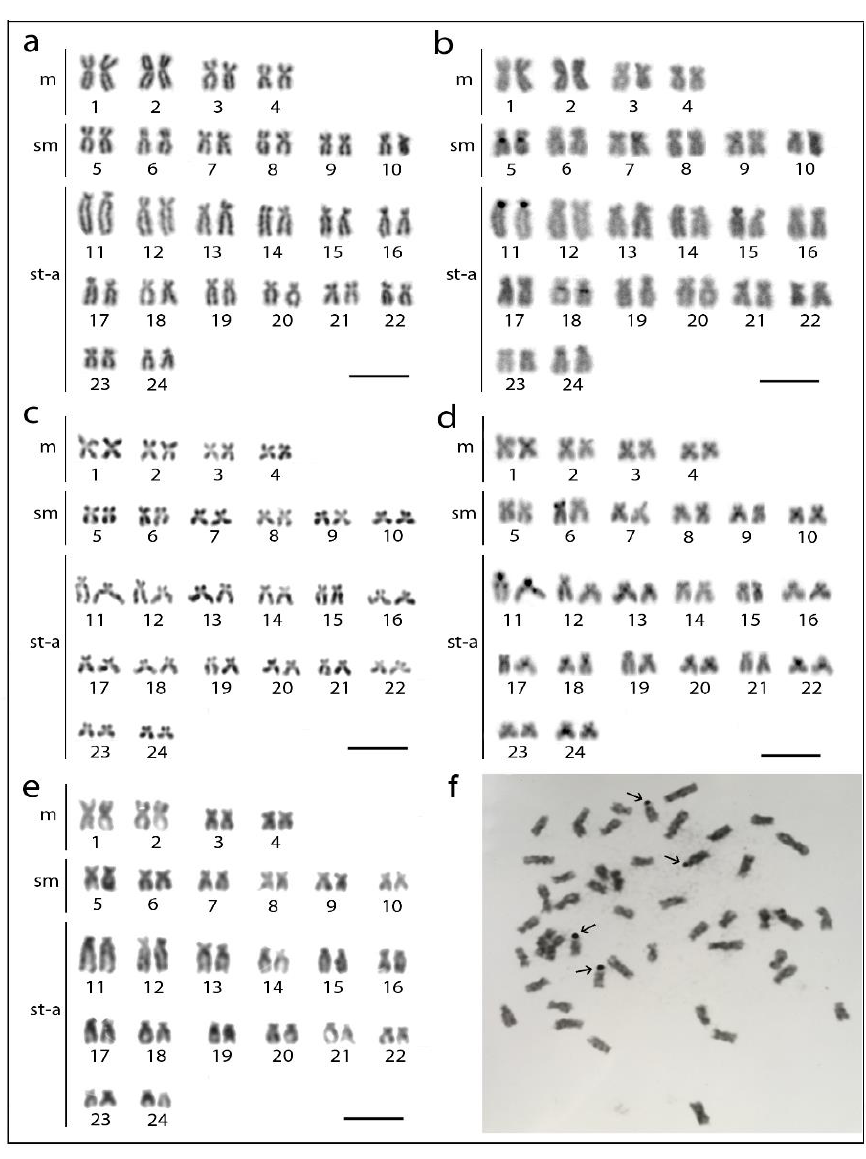
Figure 1. Karyotypes of three Hypophthalmichthys species arranged from mitotic metaphases after Giemsa staining, C-banding or Ag-NOR staining. ( a , b ) H. molitrix (individual HM3), ( c , d ) H. nobilis (individual HN4), and ( e ) H. harmandi (individual HH1). ( a , c , e ) Giemsa staining; ( b , d ) C-banding. Note two distinct blocks of constitutive heterochromatin on pair No. 11 in H. nobilis ( d ). ( f ) Ag-NOR staining in H. harmandi (individual HH3). The metaphase is incomplete (one chromosome missing; 2 n = 47), but the most representative one regarding the spreading quality and the signal strength and it is also to higher extent sufficient enough to present required features (i.e., note a lack of Ag-NOR signal on the largest acrocentric chromosome pair No. 11). Scale bar = 10 µm.